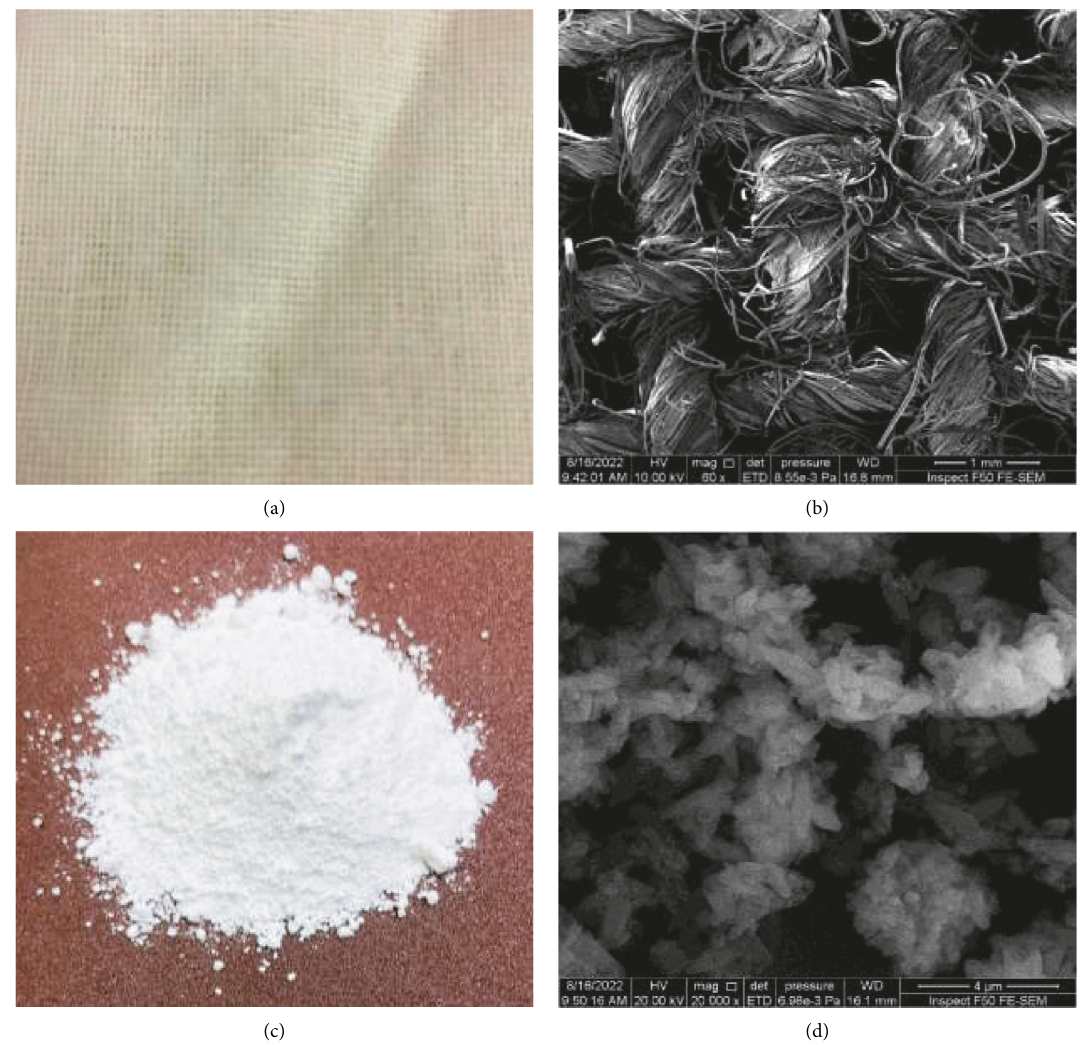
Figure 3: (a, c) Photographs of FF and SS (b and d) SEM images of FF and SS,